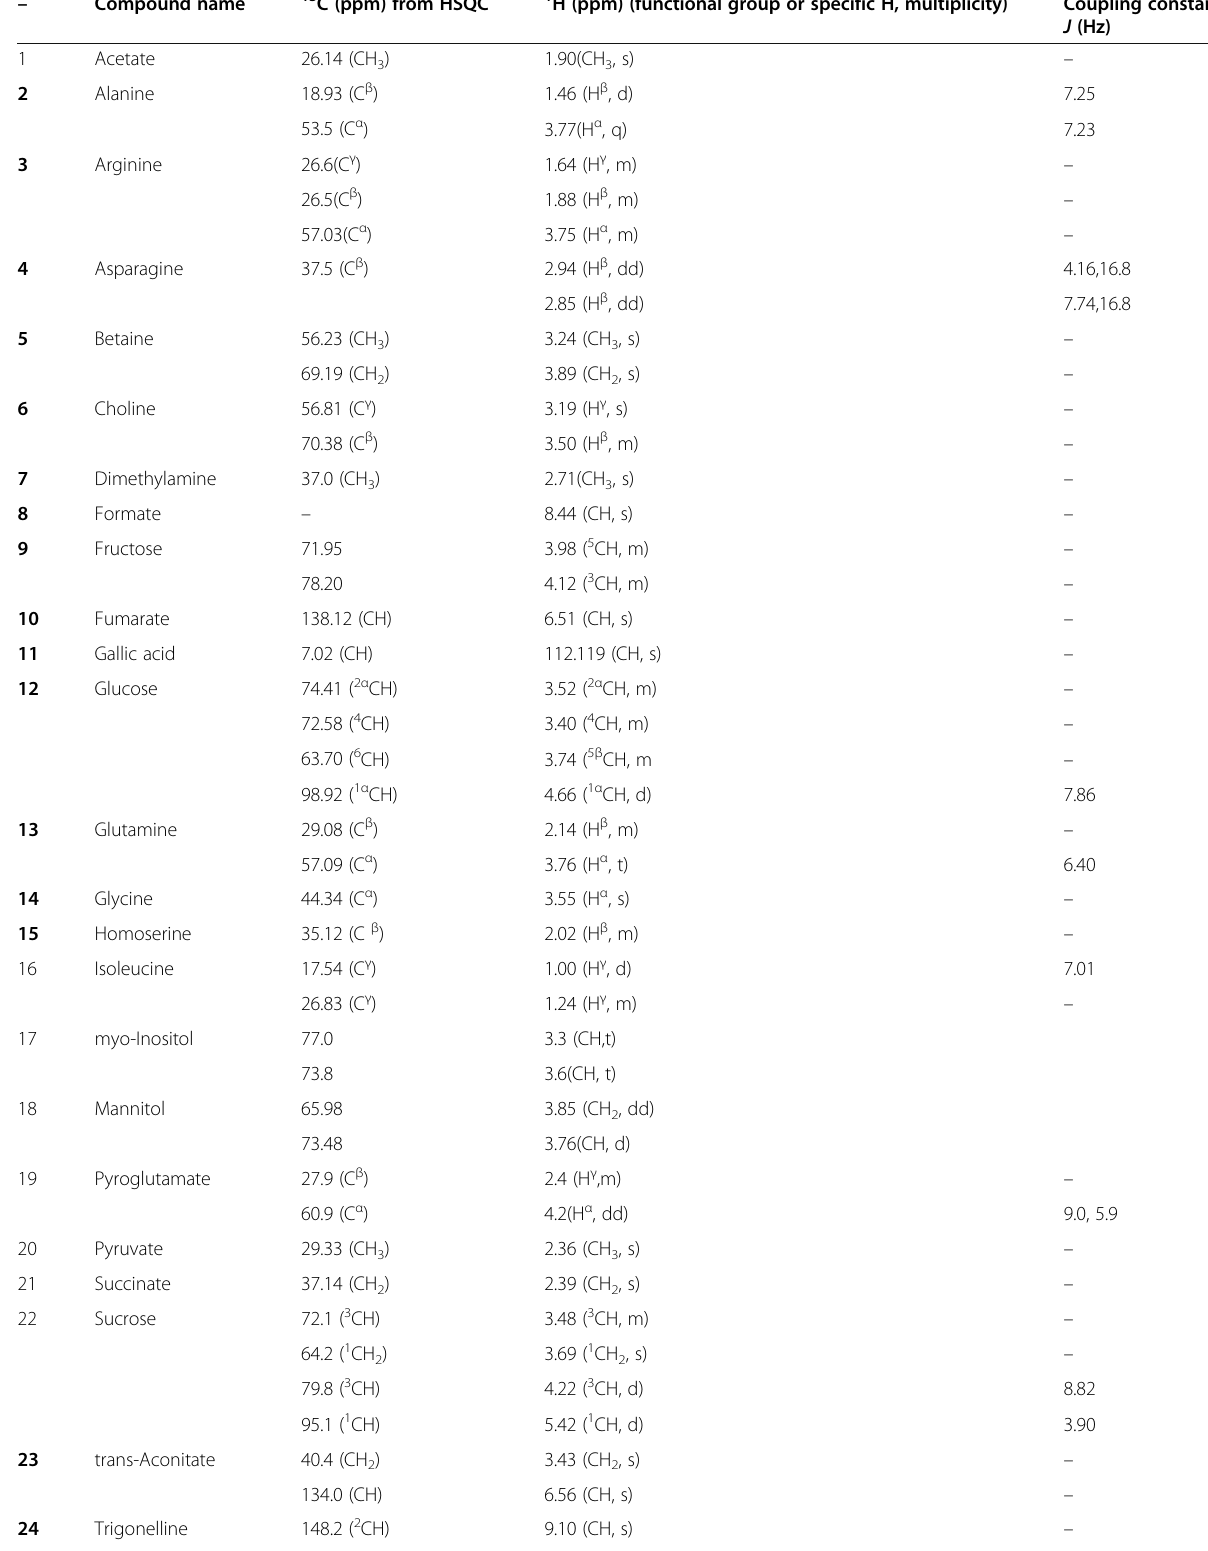
Table 1 list of metabolites identified in the polar extract of A. pubescens